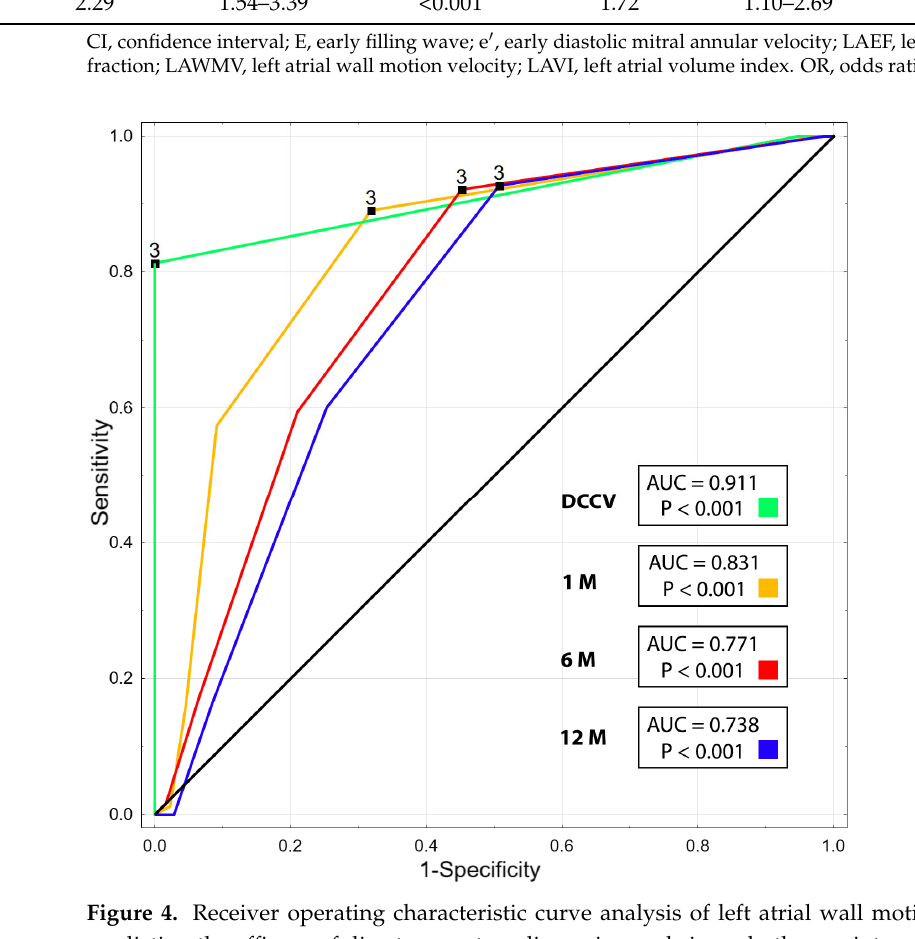
Table 5. The area under the curve analysis for LAWMV predicting sinus rhythm restoration after DCCV. Variable